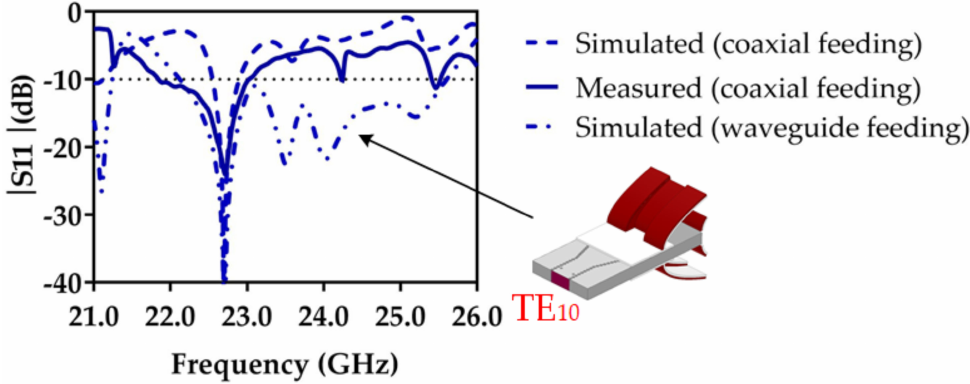
Figure 10. The reflection coefficient |S 11 | of the proposed antenna using different